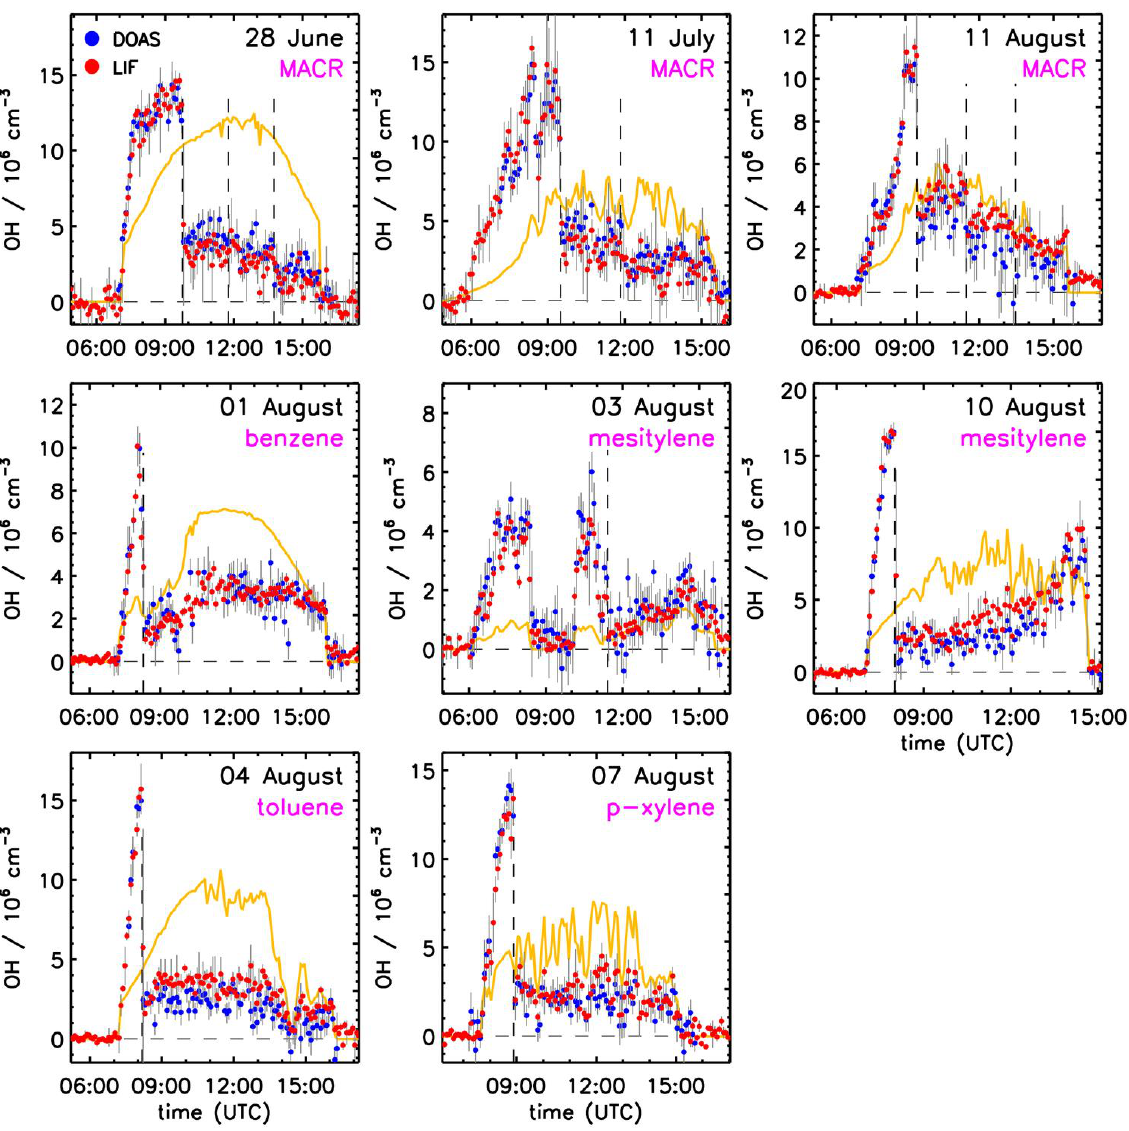
Fig. 3. Diurnal profiles of OH concentration measurements by DOAS and LIF (300s average). Grey bars are 1 σ errors of measurements. Yellow lines give the ozone photolysis frequency, j (O 1 D), inside the chamber (y-axis is scaled from 0 to 3 × 10 − 5 s − 1 in each plot). Dashed vertical lines indicate the time when OH reactants were added. No OH reactant was added during “zero air”